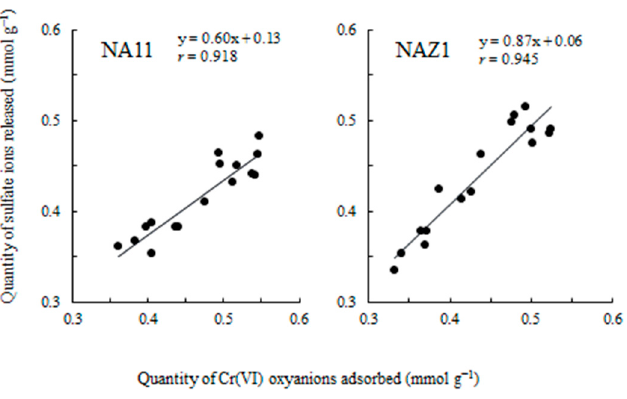
Figure 5. Relationship between quantity of Cr(VI) adsorbed and quantity of sulfate ions released.